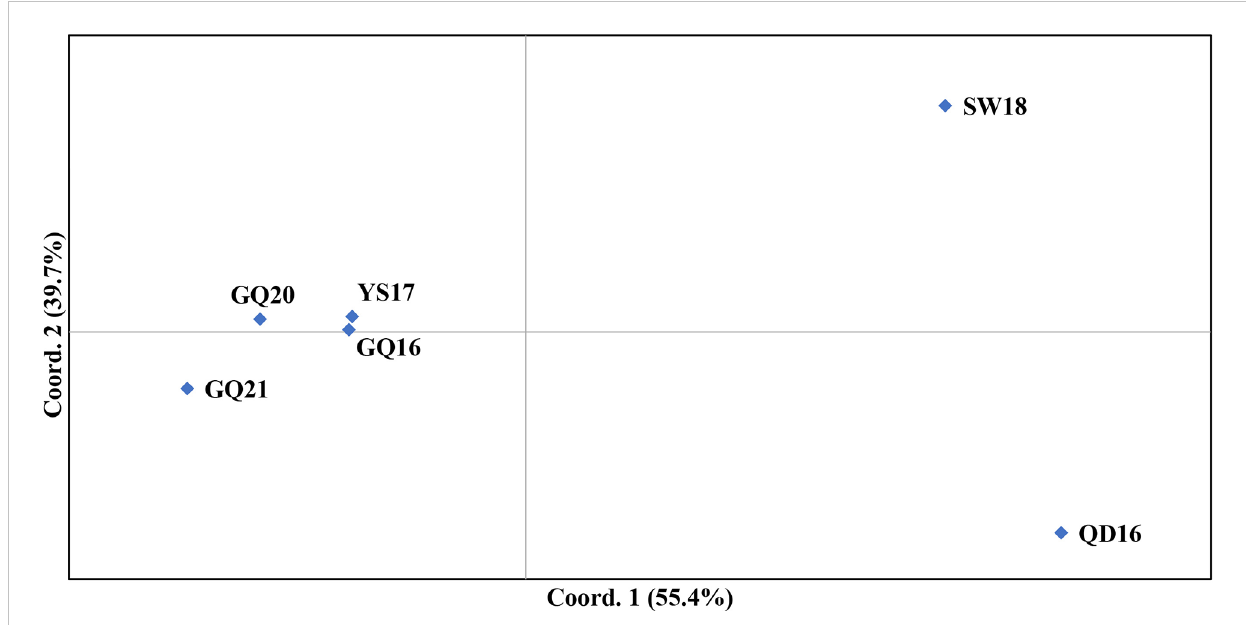
FIGURE 3 PCoA analysis result of the four native populations of Undaria pinnati fi da from southern China and two subtidal natural populations from northern China. Each population is represented by a